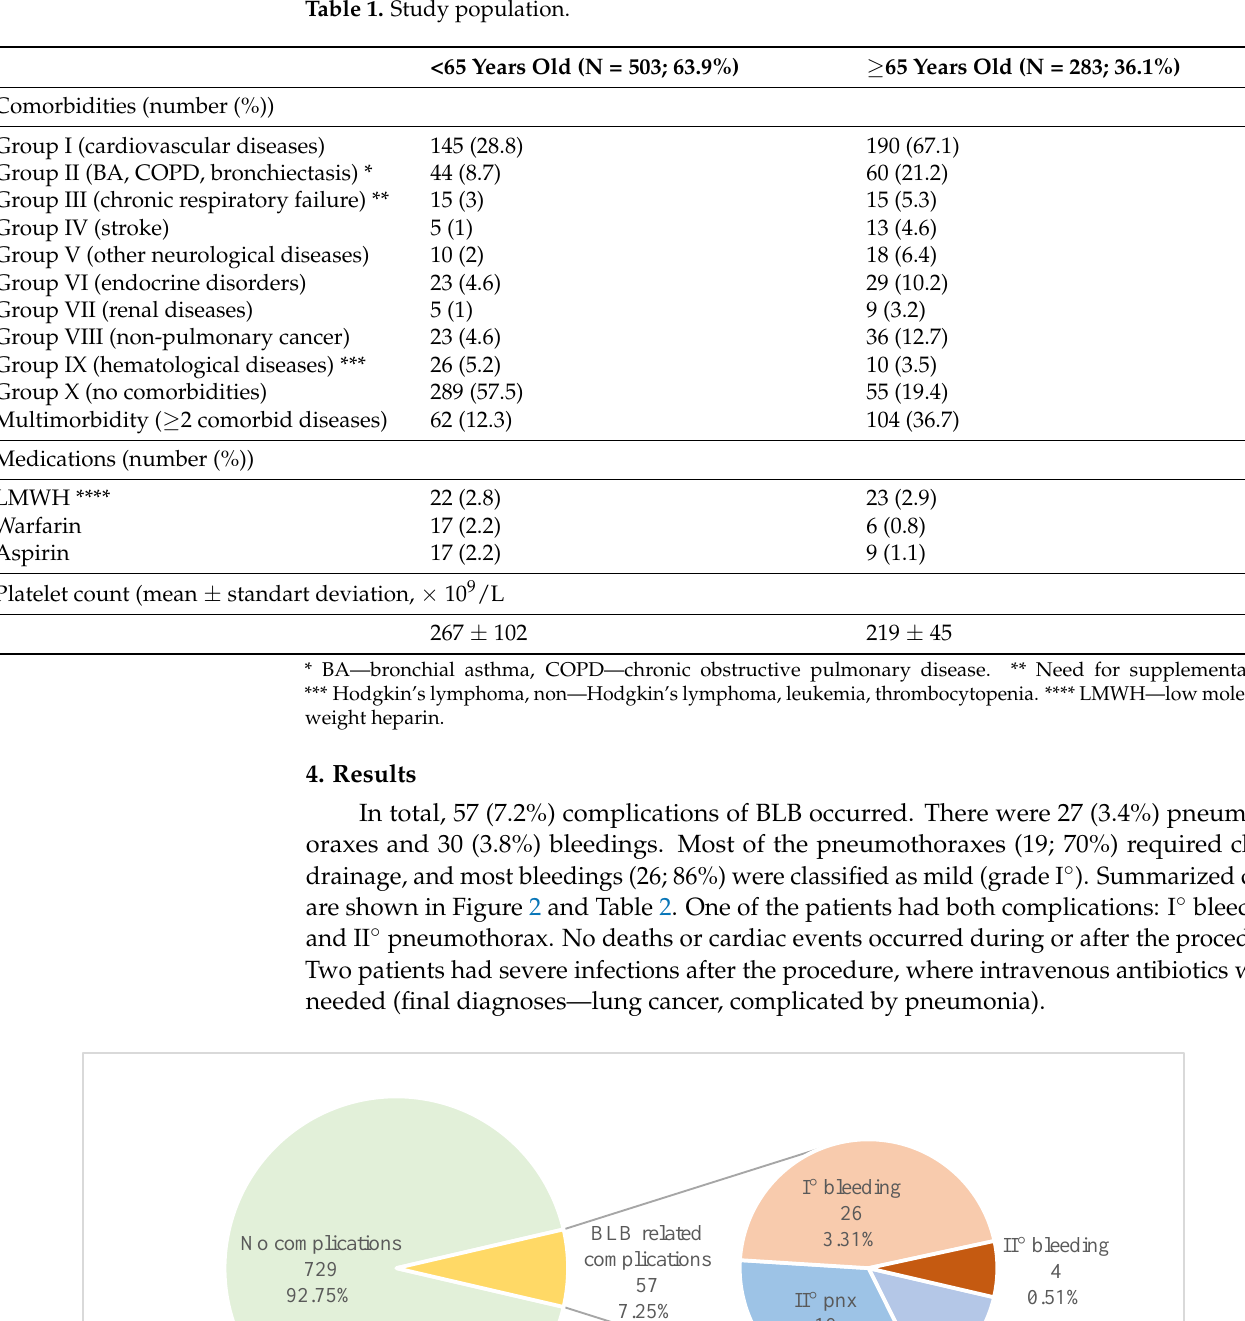
Table 1. Study population.